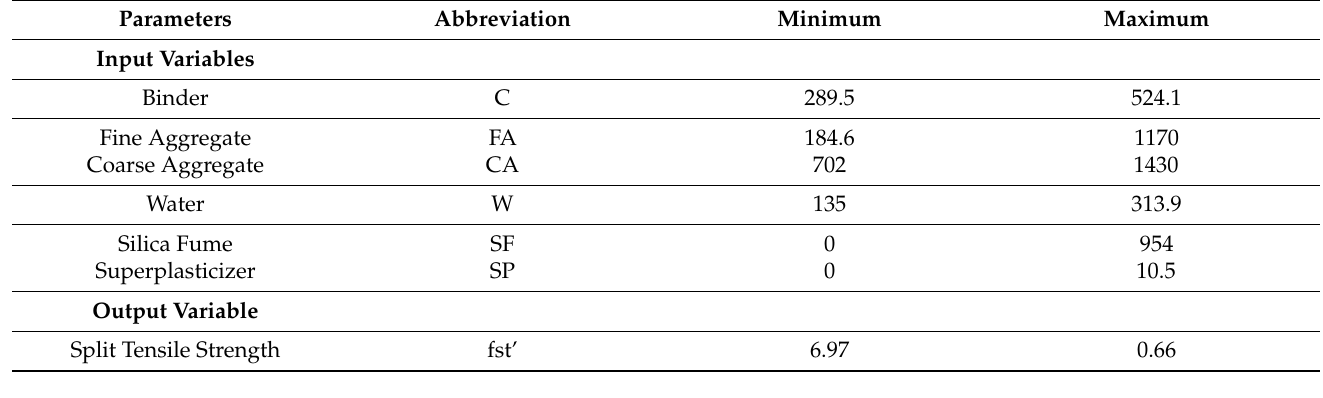
Table 5. The Maximum and Minimum Range of Silica Fume Concrete Data for Split Tensile Strength.